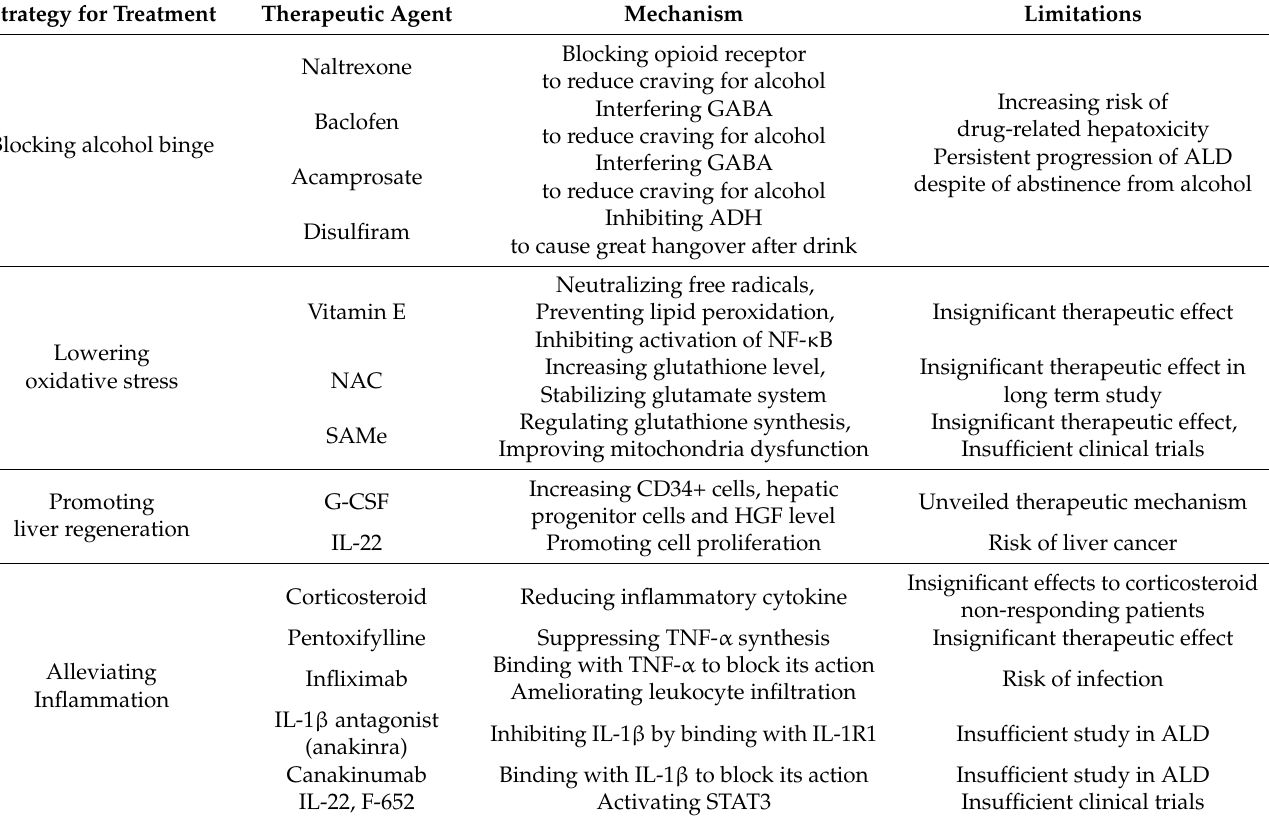
Table 1. Summary of therapeutic agents for